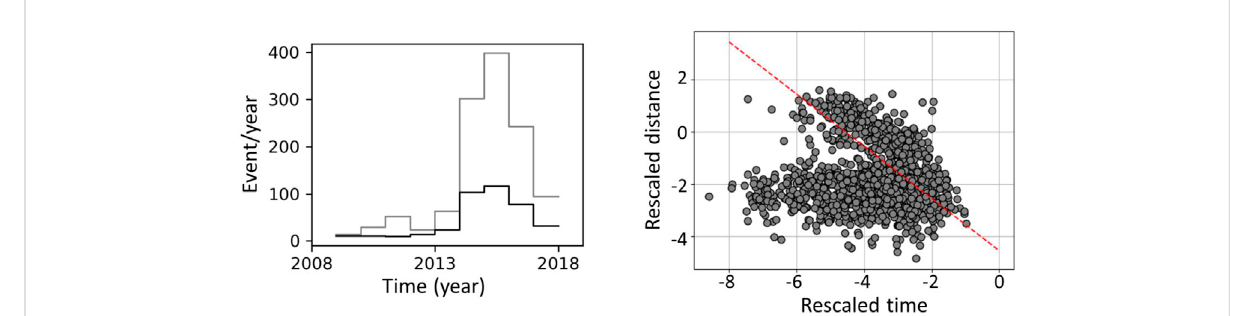
Declustering effect providing a separation between mainshocks and aftershocks induced by injection activities Left: all events of the catalogue (grey line) and independent mainshocks (black line). Right: Bimodal distribution of time and space components ( log 10 T , log 10 R ) of the nearest- neighbor distance η . Each gray circle in these plots corresponds to an event in the seismicity catalogue. The location of the event in the ( log 10 T , log 10 R ) plane provides information about the time and space distance to the event ’ s parent. The threshold value log 10 η 0 to separate the two modes is estimated used a 1D Gaussian mixture model applied to the logarithmic nearest-neighbor distances log 10 η ij (Hicks, 2011). The